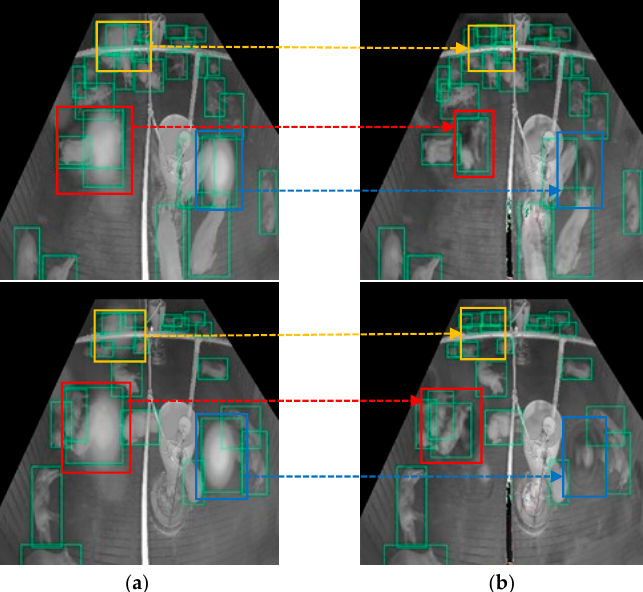
Figure 17. Detection errors in the noisy image are fixed after applying the proposed denoising method: ( a ) pig detection results on real-noisy image, the detection result in the noisy area is highlighted in yellow, red and blue box. ( b ) pig detection results on the denoised image by the proposed model, the detection result on the denoised area in highlighted in yellow, red and blue box.